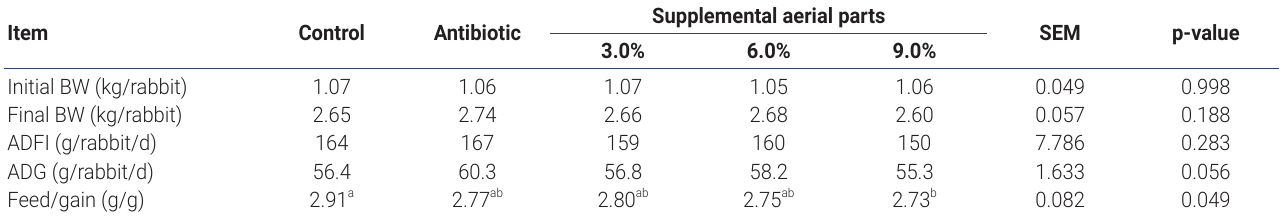
Table 3. Effect of Salvia miltiorrhiza aerial parts on the growth performance of rabbits